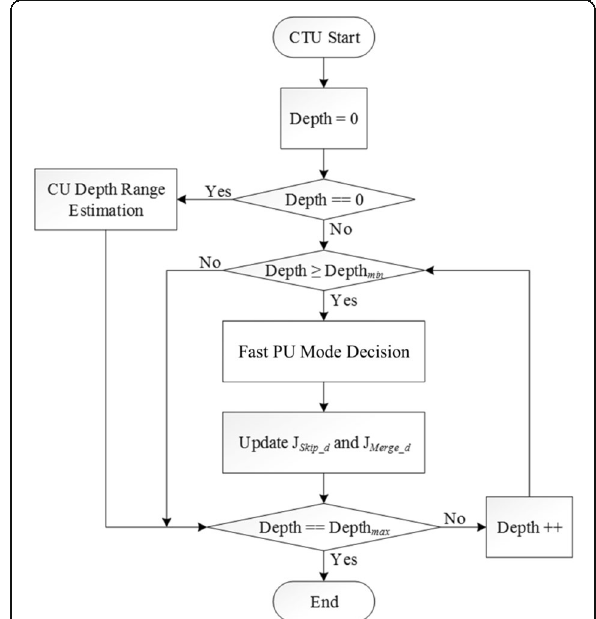
Fig. 5 The flowchart of the fast CU